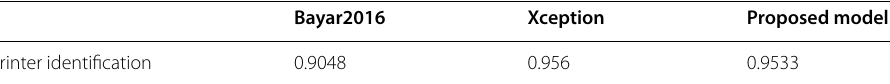
We investigate the variation of the images between printers by training each model to discern between printers. The high accuracy indicates that the images produces by each printer vary